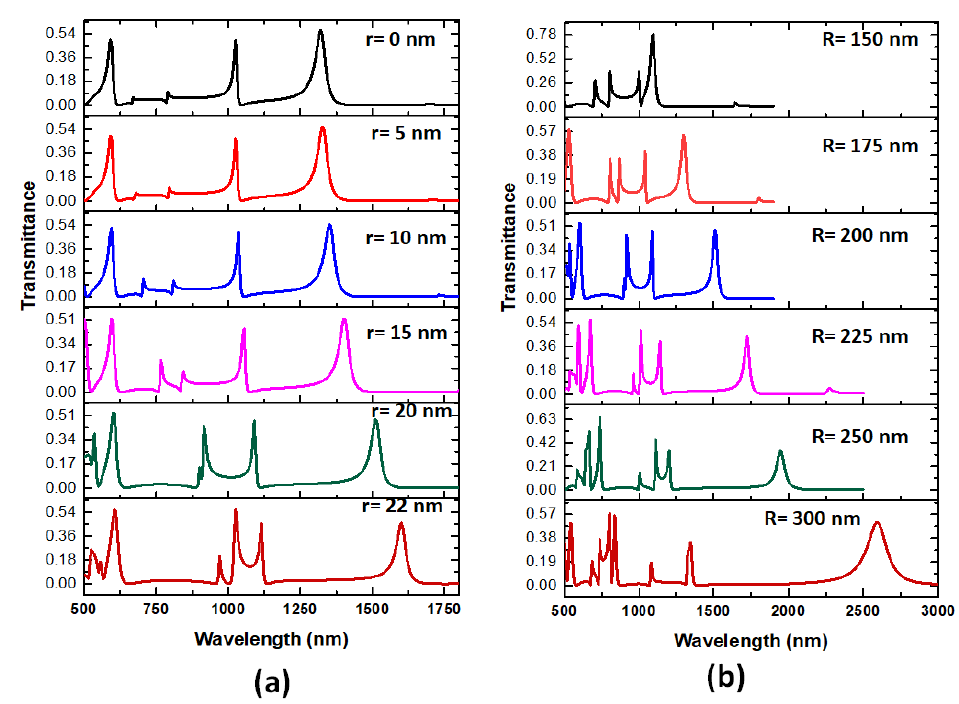
Figure 5. Transmittance spectrum of case 4 by varying ( a ) r = (0, 5, 10, 15, 20, 22) nm, and ( b ) R x = (150, 175, 200, 225, 250, 300) nm, respectively.